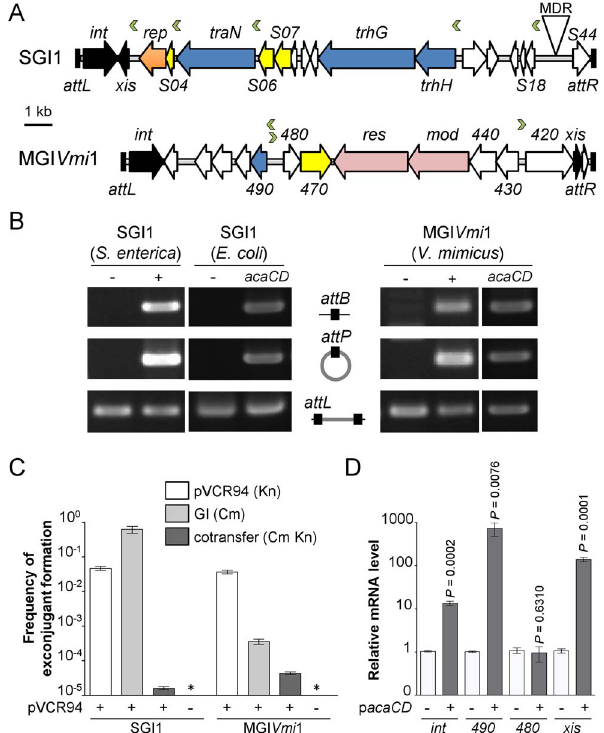
Figure 4. IncA/C-dependent excision and transfer of GIs. (A) Schematic representation of SGI1 from S. enterica Typhimurium DT104 and MGI Vmi 1 from V. mimicus VM573. The left and right junctions ( attL and attR ) within the host chromosome are indicated. SGI1 (42 596 bp, Genbank AF261825) and MGI Vmi 1 (16 511 bp, Genbank NZ_A- CYV01000005) are integrated into the 3 9 end of trmE and yicC (